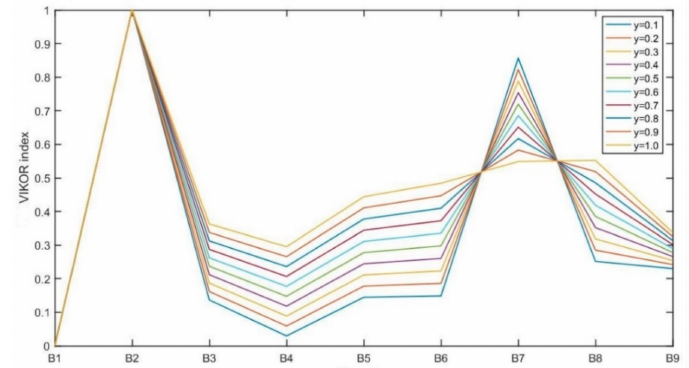
Figure 2. VIKOR index for all γ